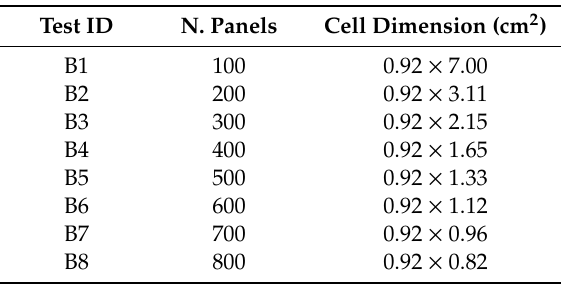
Table A1. Characteristics of the different meshes considered for the sensitivity analysis, with a fixed number of slices equal to 20.